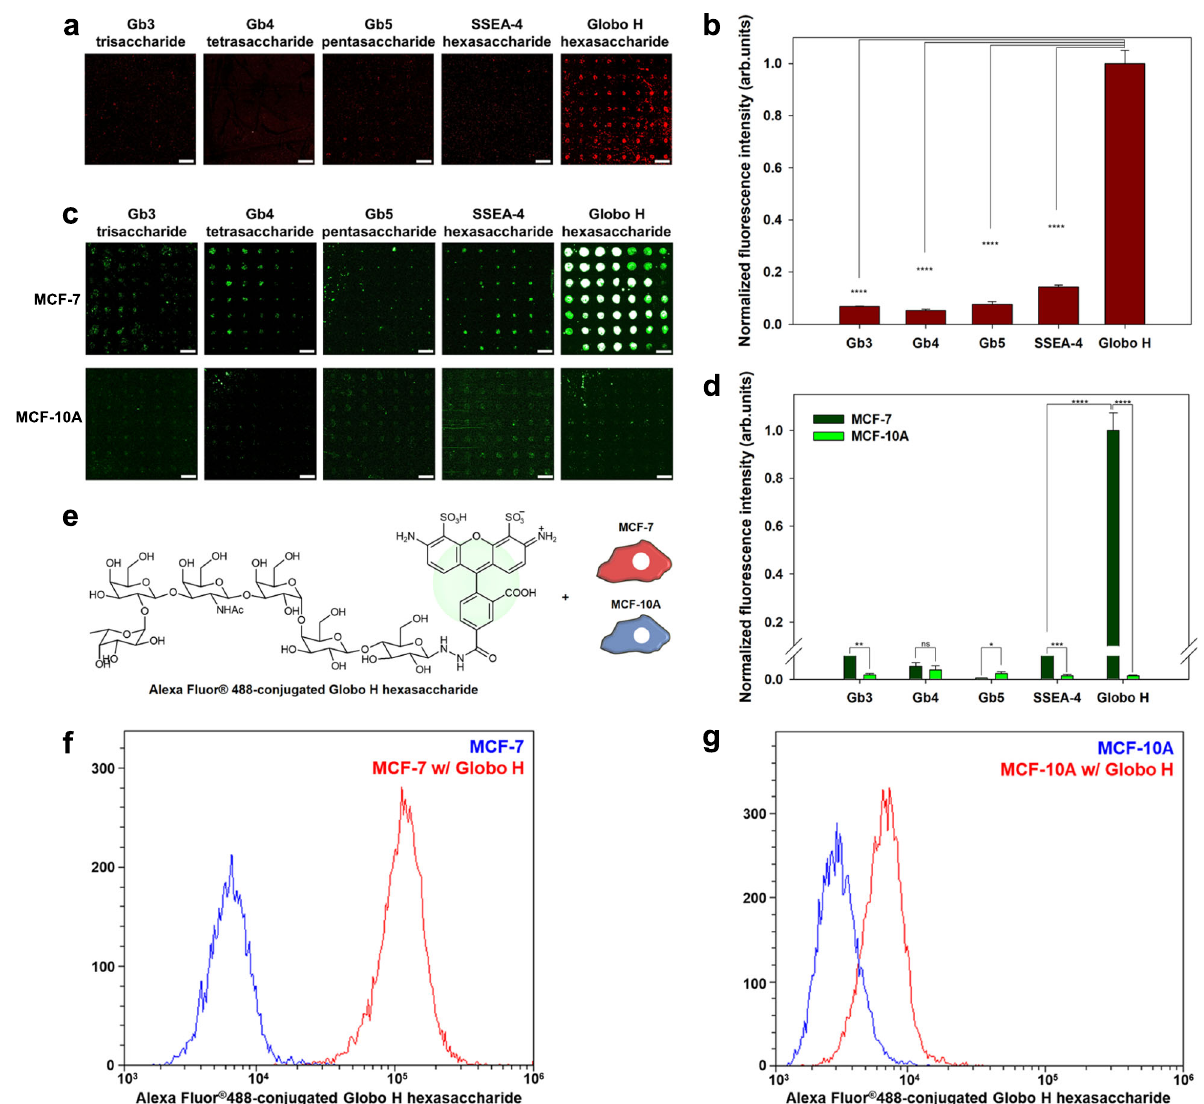
Fig. 4 Applications of structure-switchable DNA-based glycan chips. a , b Analysis of the glycan-binding speci fi city of the VK9 antibody on the glycan chip. a Scanned raw images and ( b ) quantitative fl uorescence intensity plot for the binding of VK9 with biosynthesized Gb3 trisaccharide, Gb4 tetrasaccharide, Gb5 pentasaccharide, SSEA-4 hexasaccharide, and Globo H hexasaccharide (Scale bar: 800 μ m). c , d Analysis of glycan-binding speci fi city of MCF-7 breast cancer cells on the glycan chip. c Scanned raw images and ( d ) quantitative fl uorescence intensity plot for the binding of MCF-7 breast cancer and MCF-10A normal breast cells with on-chip biosynthesized Gb3 trisaccharide, Gb4 tetrasaccharide, Gb5 pentasaccharide, SSEA-4 hexasaccharide, and Globo H hexasaccharide (Scale bar: 800 μ m). Each value presents the mean ±SEM from forty-nine independent spots excluding the highest and lowest signals. Statistical signi fi cance was assessed using Student ’ s unpaired t test (* p < 0.05; ** p < 0.01; *** p < 0.001; **** p < 0.0001). e Schematic presentation for analyzing the binding of MCF-7 breast cancer and MCF-10A normal breast cells to Globo H hexasaccharide using fl ow cytometry. FACS analyses for the binding of ( f ) MCF-7 breast cancer and ( g ) MCF-10A normal breast cells with Globo H hexasaccharide. Source data are provided as a Source Data fi